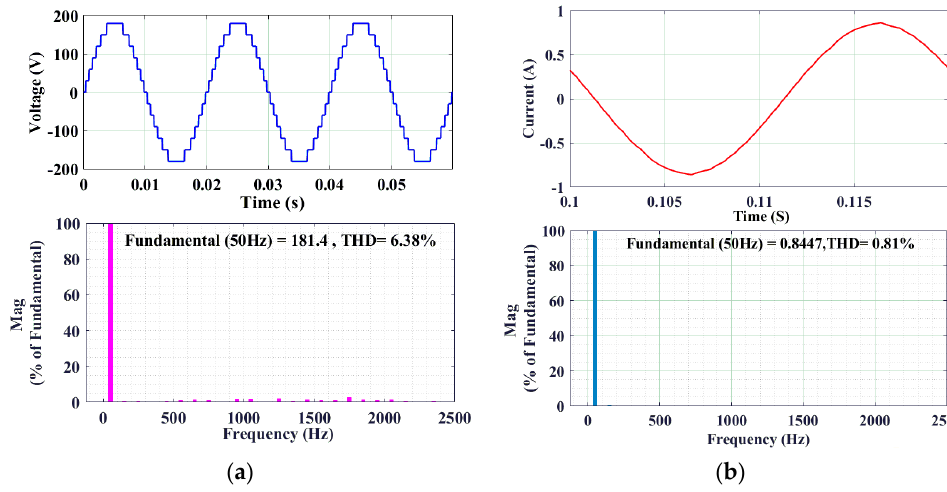
Figure 7. Simulation output waveform with FFT analysis: ( a ) voltage and ( b ) current. Table 3. Important parameters with simulation results.